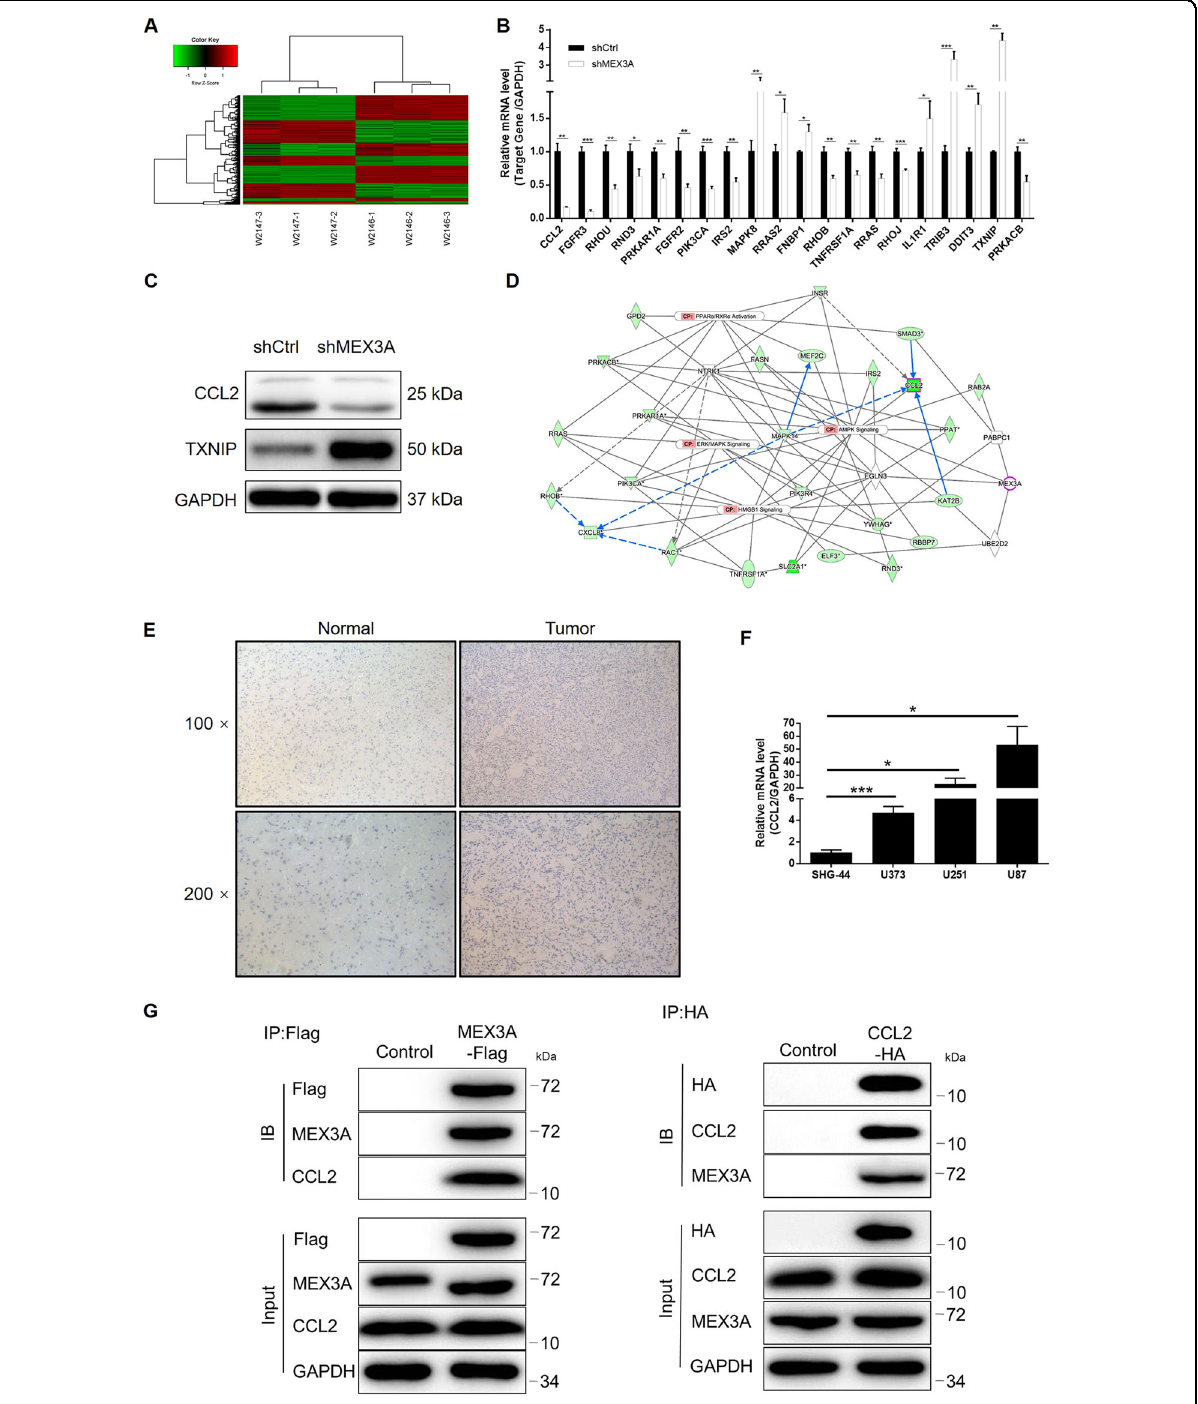
Fig. 4 The exploration and veri fi cation of downstream-underlying MEX3A-induced regulation of glioma. A A PrimeView human gene expression array was performed to identify the differentially expressed genes (DEGs) between shMEX3A and shCtrl groups of U251 cells. B qPCR and C western blotting were used to detect the expression of several selected DEGs in U251 cells with or without MEX3A. D A MEX3A-associated interaction network constructed by IPA analysis revealed the potential linkage between MEX3A and CCL2. E The expression of CCL2 in glioma and normal tissues was evaluated by IHC analysis. F The mRNA expression of MEX3A in U87, U251, U373, and SHG-44 cell lines was detected by qPCR. G A co-IP assay was performed to show the direct interaction between MEX3A and CCL2. The representative images were selected from at least three independent experiments. Data were shown as mean ± SD. * P < 0.05, ** P < 0.01, *** P <